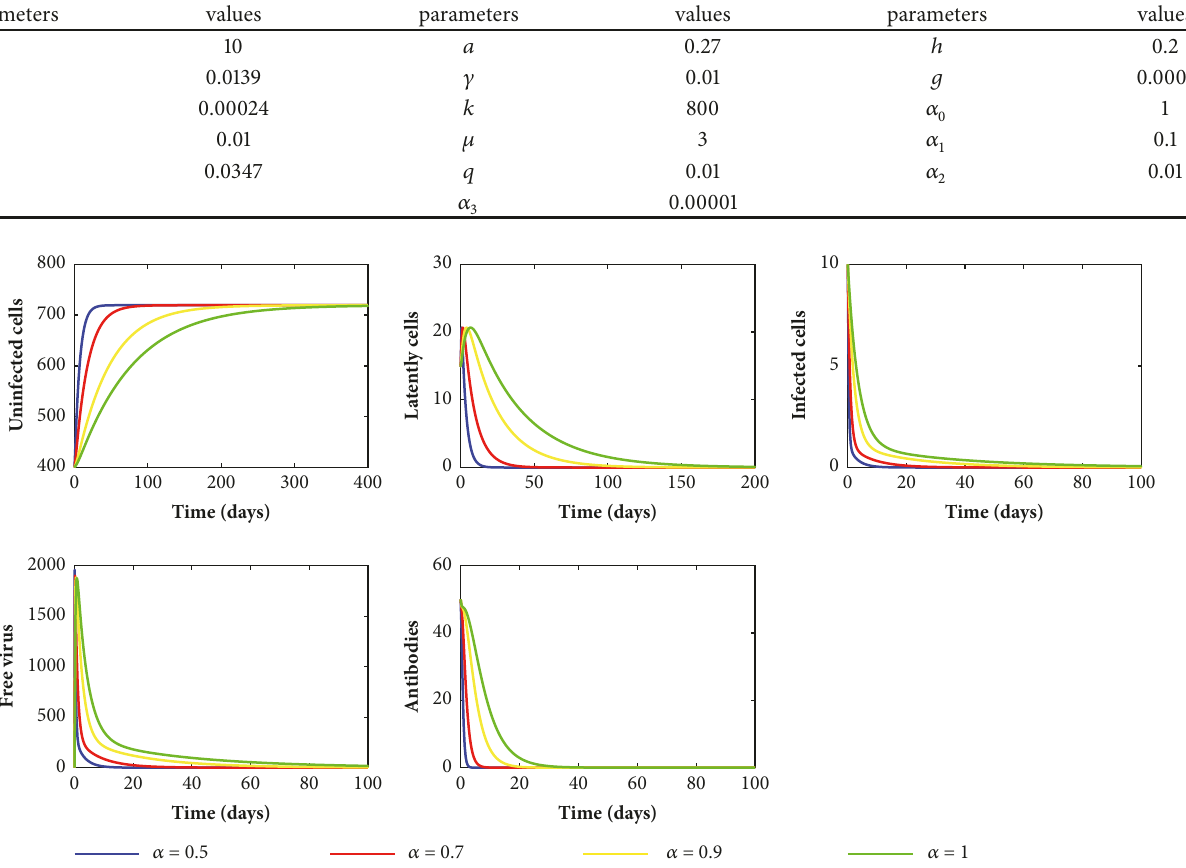
Table 1: Parameter values of system (1).